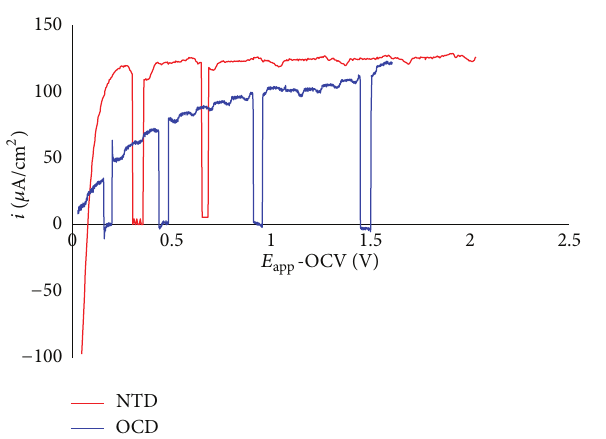
Figure2:Trendofcurrentdensityasafunctionoftheoverpotential, obtained at NTD (red curve) and OCD (blue curve) in 0.1MKOH solution under irradiation of a Xenon lamp equipped with a 400 nm filter. The points of light-off are well evidenced in the curves.